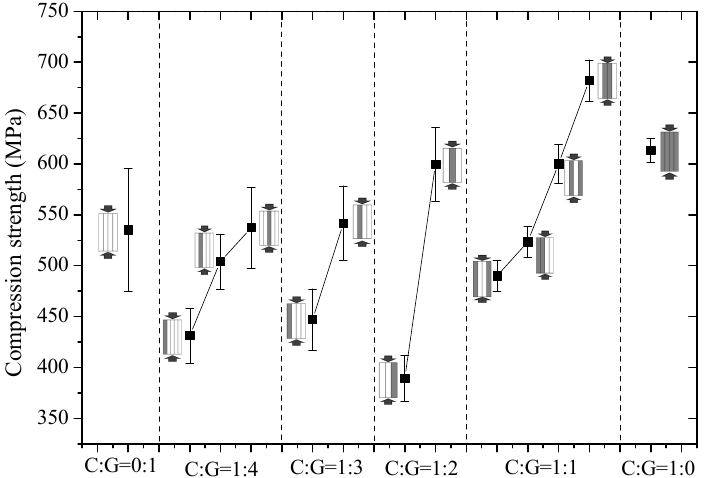
Figure 6. Compression strength of different stacking sequences with various C/G ratios.